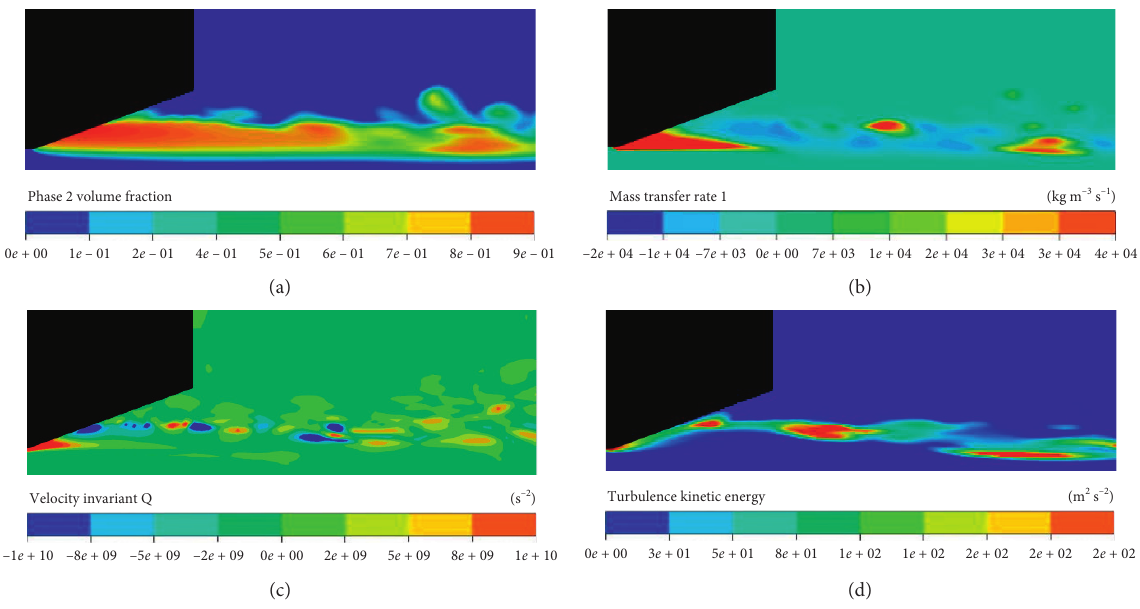
Figure 12: Distribution of variables at the angular nozzle outlet. (a) Vapor volume fraction. (b) Mass transfer rate. (c) Q- criteria. (d) Turbulence kinetic energy.